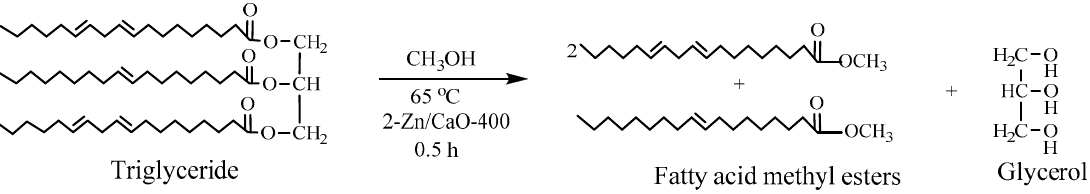
Figure S3: Progress of aminolysis using FTIR; Figure S4: Mass spectra of fatty acid amide derived from methyl laurate; Table S1: The chemical analysis of vegetable